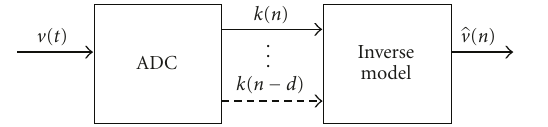
Figure 1: Postcorrection by using an inverse model of the ADC.